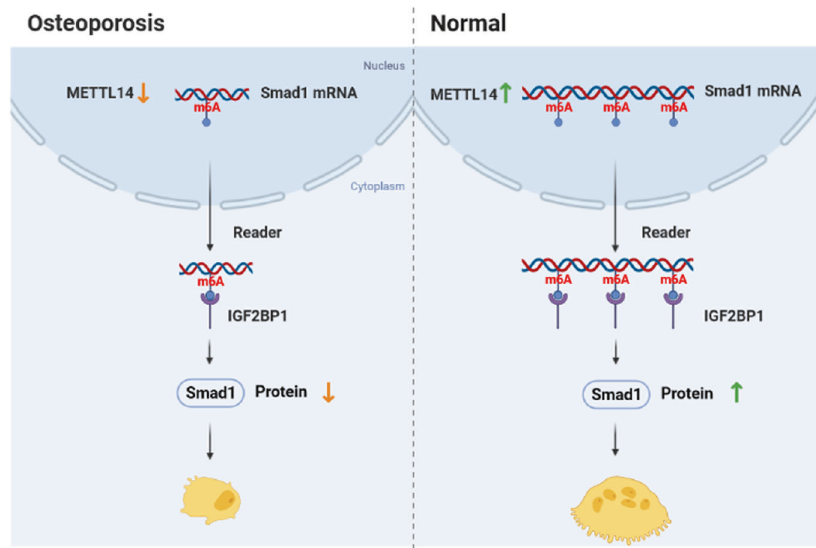
Fig. 9 A graphic illustration shows the METTL14/SMAD1 axis in OP. In OP, METTL14 was downregulated and inhibited m6A methylation of SMAD1. The methylation suppression was regulated by m6A reader IGF2BP1, leading to the degradation of SMAD1 at mRNA and protein levels. In normal, METTL14 promoted m6A methylation of SMAD1 by modulating IGF2BP1, increasing SMAD1 protein